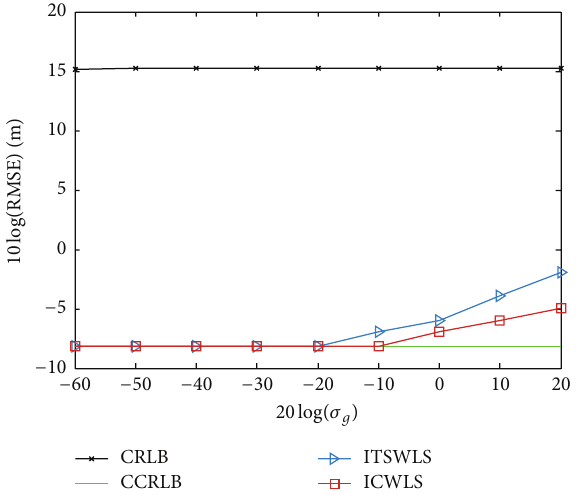
Figure 3: Comparison of target geolocation RMSEs of ITSWLS and ICWLS as a function of 𝜎 𝑔